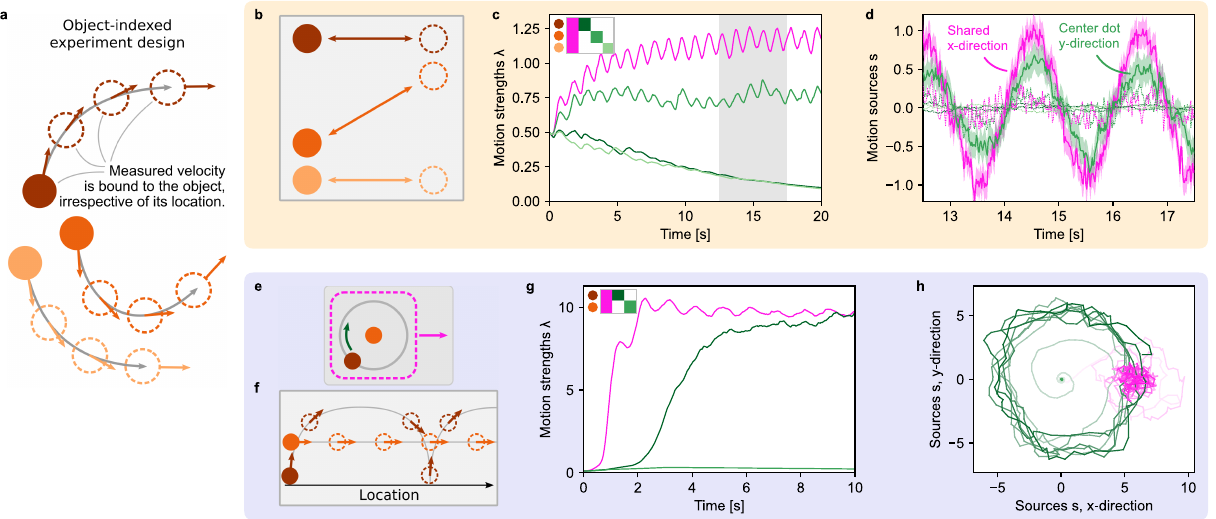
Fig. 2 | Online hierarchical inference replicates human perception of classical motion displays. a In object-indexed experiment designs, every observable velo- city is bound to an object irrespective of its location. Many psychophysics studies fall into this class of experiment design. b Johansson ’ s 3-dot motion display. Humans perceive the stimulus as shared horizontal motion with the central dot oscillating vertically between the outer dots. c The online model ’ s estimate of the motion strengths, λ t (a single motion strength is shared across both spatial dimensions). The component matrix, C , is shown in the top-left as a legend for the line colors. Circles next to the matrix show the assignment of the rows in C to the dots in panel b . d The model ’ s posterior distribution over the motion sources, s t ,